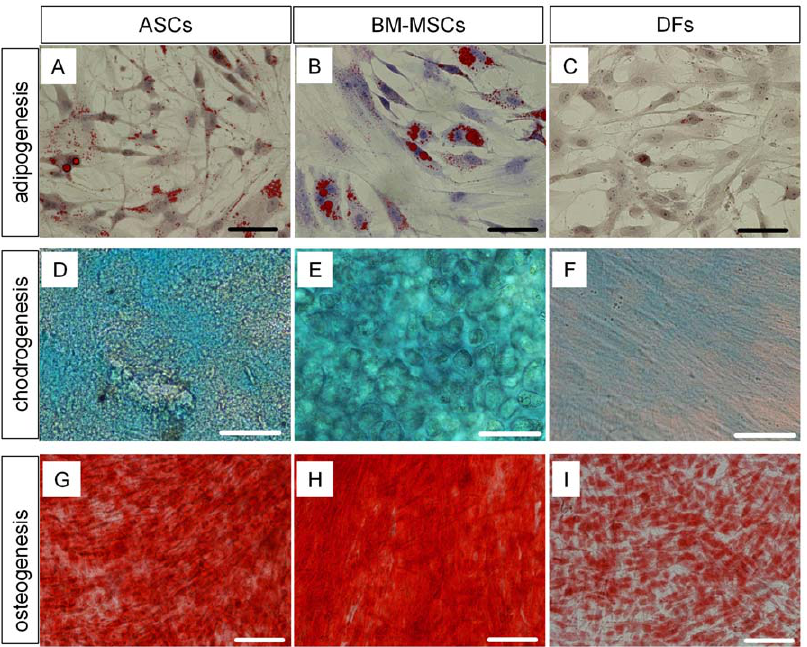
Figure 2. Rabbit MSCs differentiate to mesodermal lineages invitro . Passage 2 ASCs (A, D, G), BM-MSCs (B, E, H), and DFs (C, F, I) were used for differentiation. (A–C): Adipogenic differentiation. Cells were cultured in adipogenesis differentiation medium for 8 days. Oil Red O staining was performed to detect lipid accumulation. Nuclei were stained with Hematoxylin. (D–F): Chondrogenic differentiation. Cells were cultured in chondrogenesis differentiation medium for 21 days. Alcian blue staining was performed. (G–I): Osteogenic differentiation. Cells were cultured in osteogenesis differentiation medium for 35 days. Alizarin Red S staining was performed to detect calcium accumulation. Abbreviation: MSCs, mesenchymal stem cells; ASCs, adipose derived stem cells; DFs, dermal fibroblasts; BM-MSCs, bone marrow derived mesenchymal stem cell. Scale